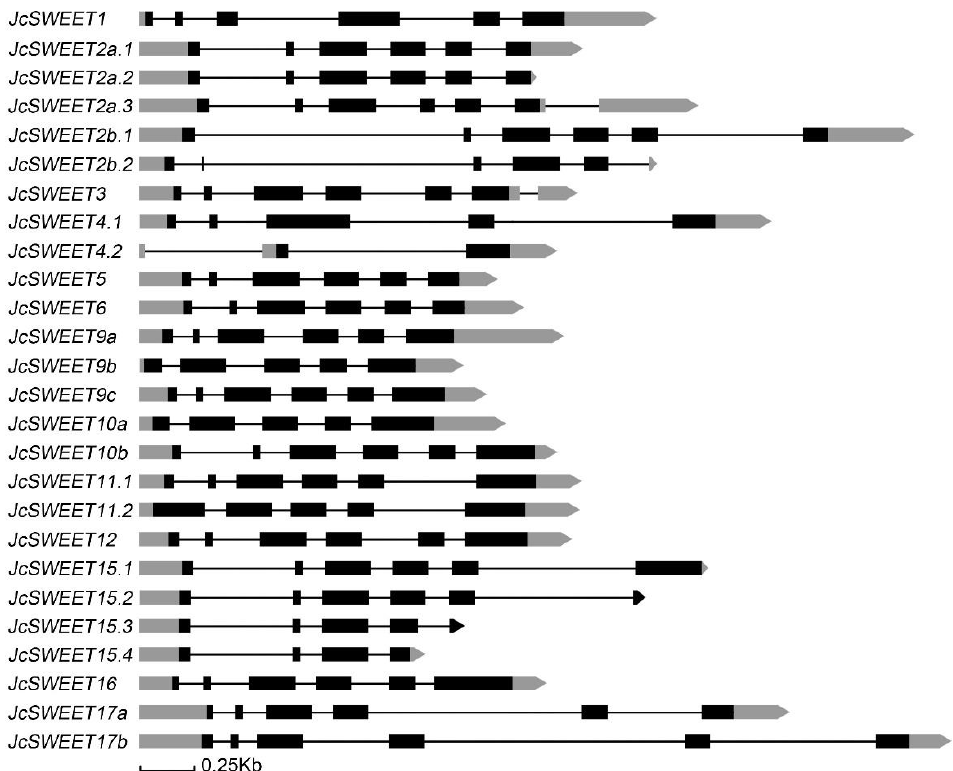
Figure 2. Structures of the 18 JcSWEET genes. The exons are shown as boxes (coding sequence (CDS) in black, untranslated region (UTR) in gray), while the introns are represented by lines.